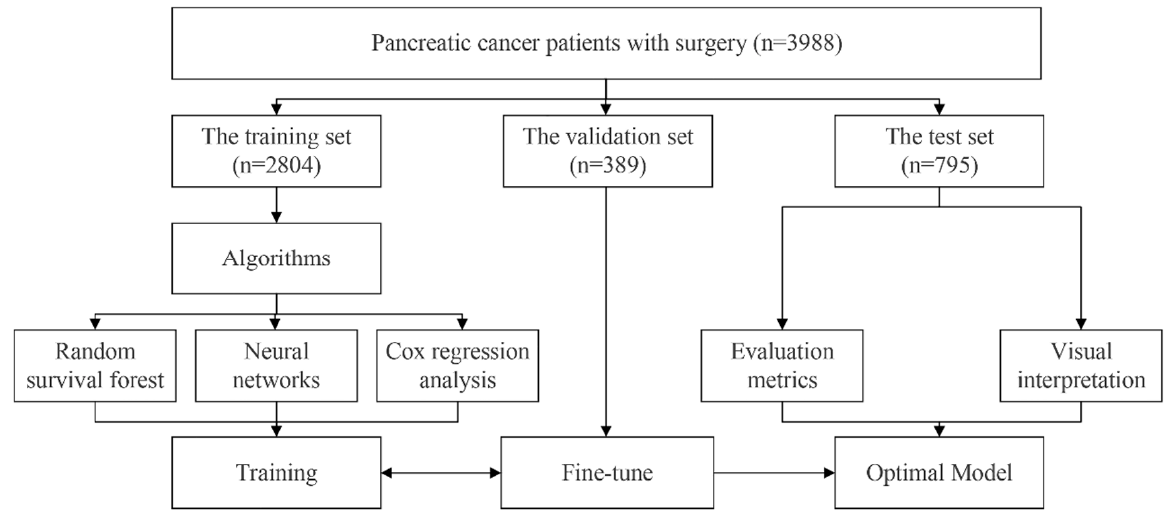
Figure 1. The flowchart of developing models.